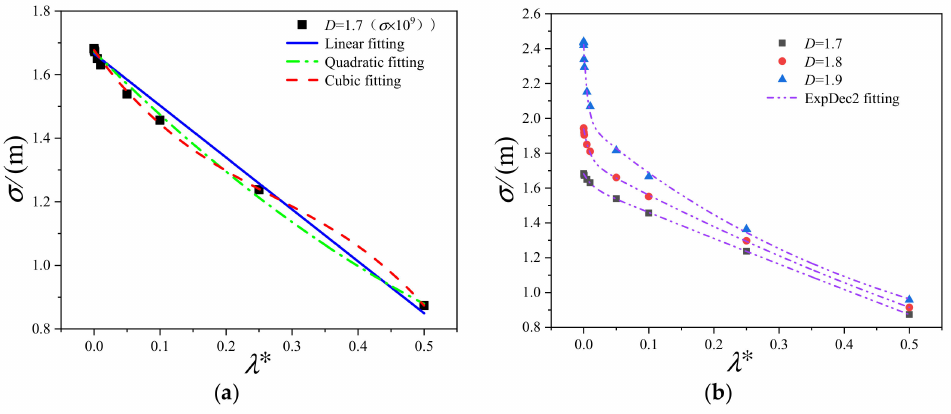
Figure 4. Different fitting curves between the dimensionless observation length and the standard deviation at different fractal dimensions. ( a ) Linear fitting, Quadratic fitting and Cubic fitting at D = 1.7. ( d ) ExpDec2 fitting at D = 1.7, 1.8 and